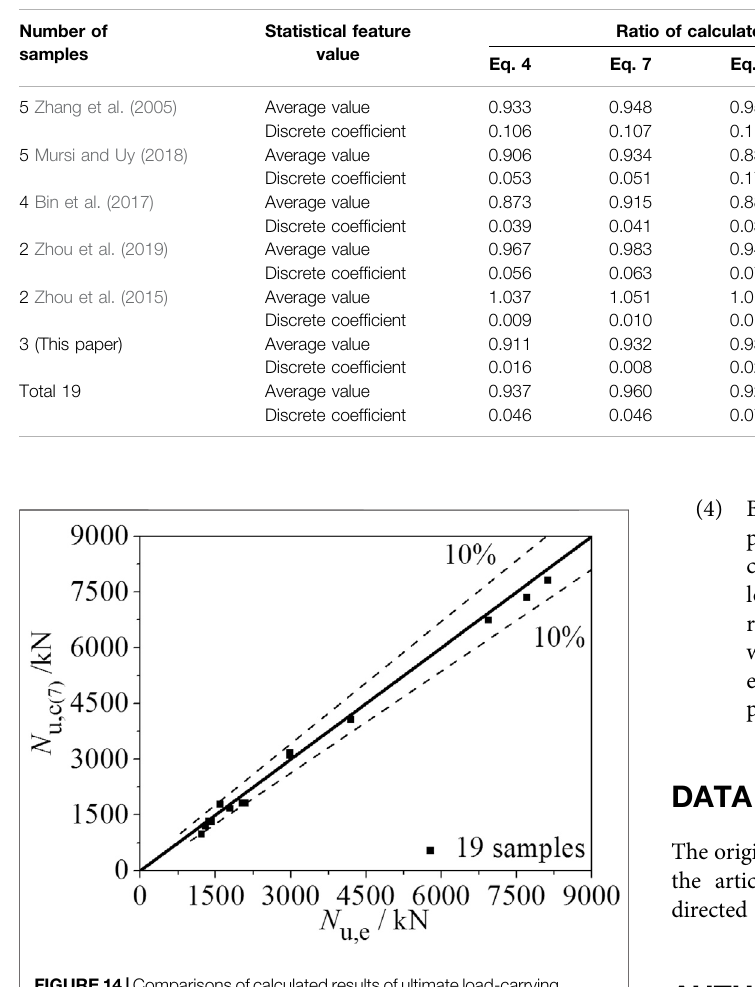
FIGURE14| Comparisonsofcalculatedresultsofultimateload-carrying capacity using Eq. (7) ( N u,c(7) ) to experimental results ( N u,e